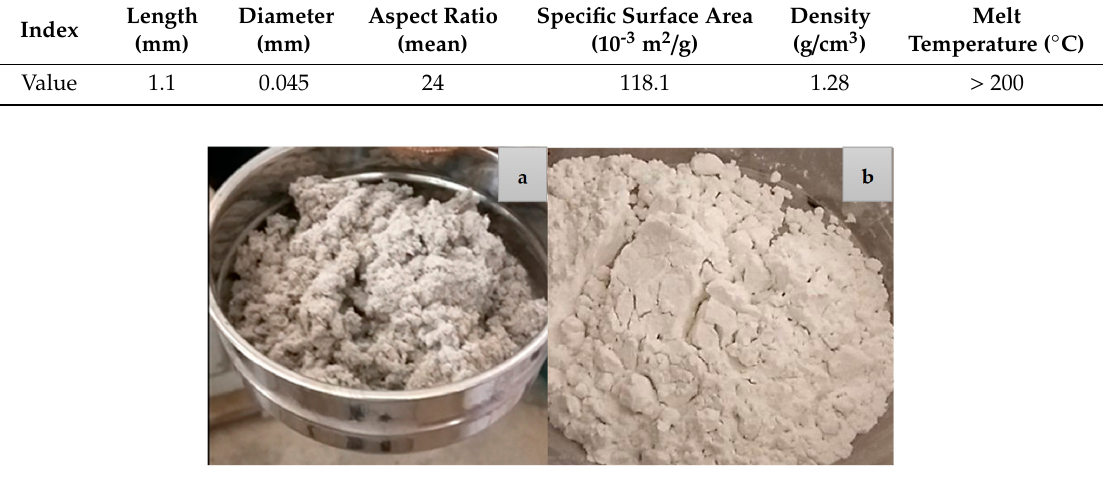
Table 5. Fundamental characteristics of diatomite.